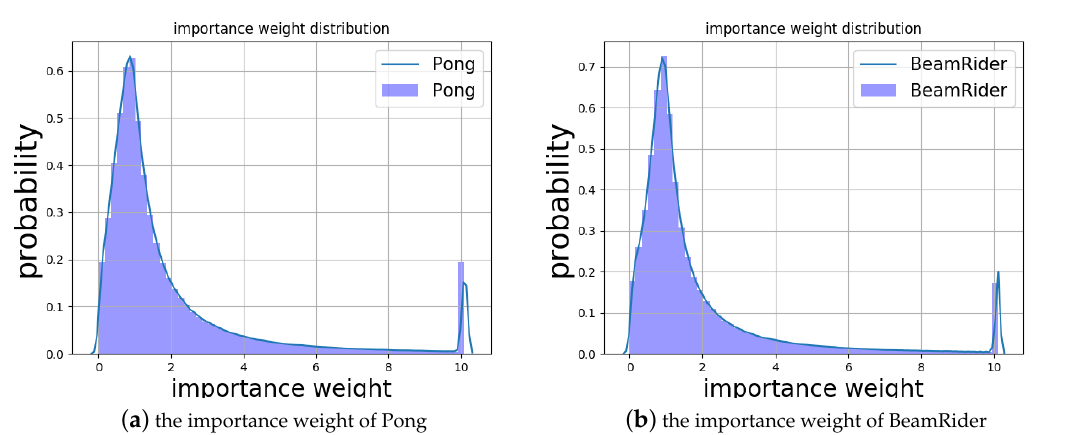
Figure 6. The distribution of importance weight on Atari tasks. The bars represent statistical histograms, and the curves are the corresponding kernel density